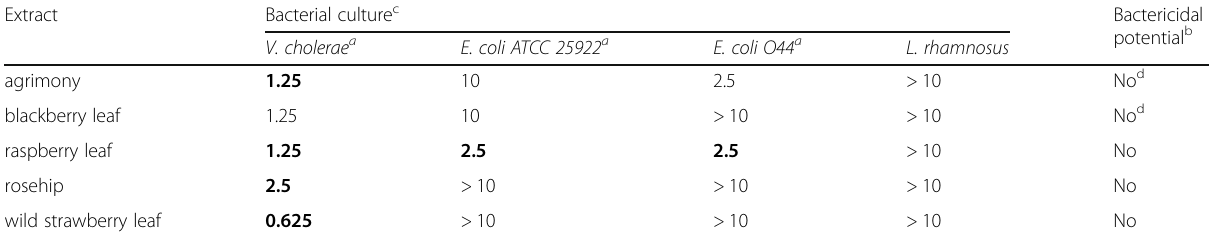
Table 4 Concentration of plant extracts to reduce bacterial culture densities by 50% Extract Bacterial culture c